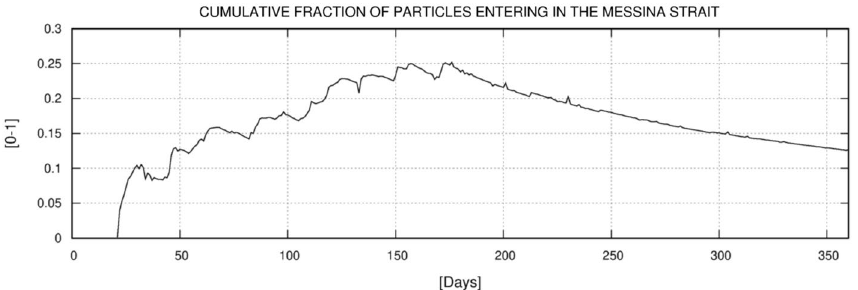
Figure 11. The cumulative ratio between the total amount of particles entering in the Strait and the amount of particles released within the spawning areas and still within the model domain. The results were post-processed and averaged on a daily basis in order to obtain a whole year dataset from the two-year simulation runs results. The time series of the ratio is reported as a function of the